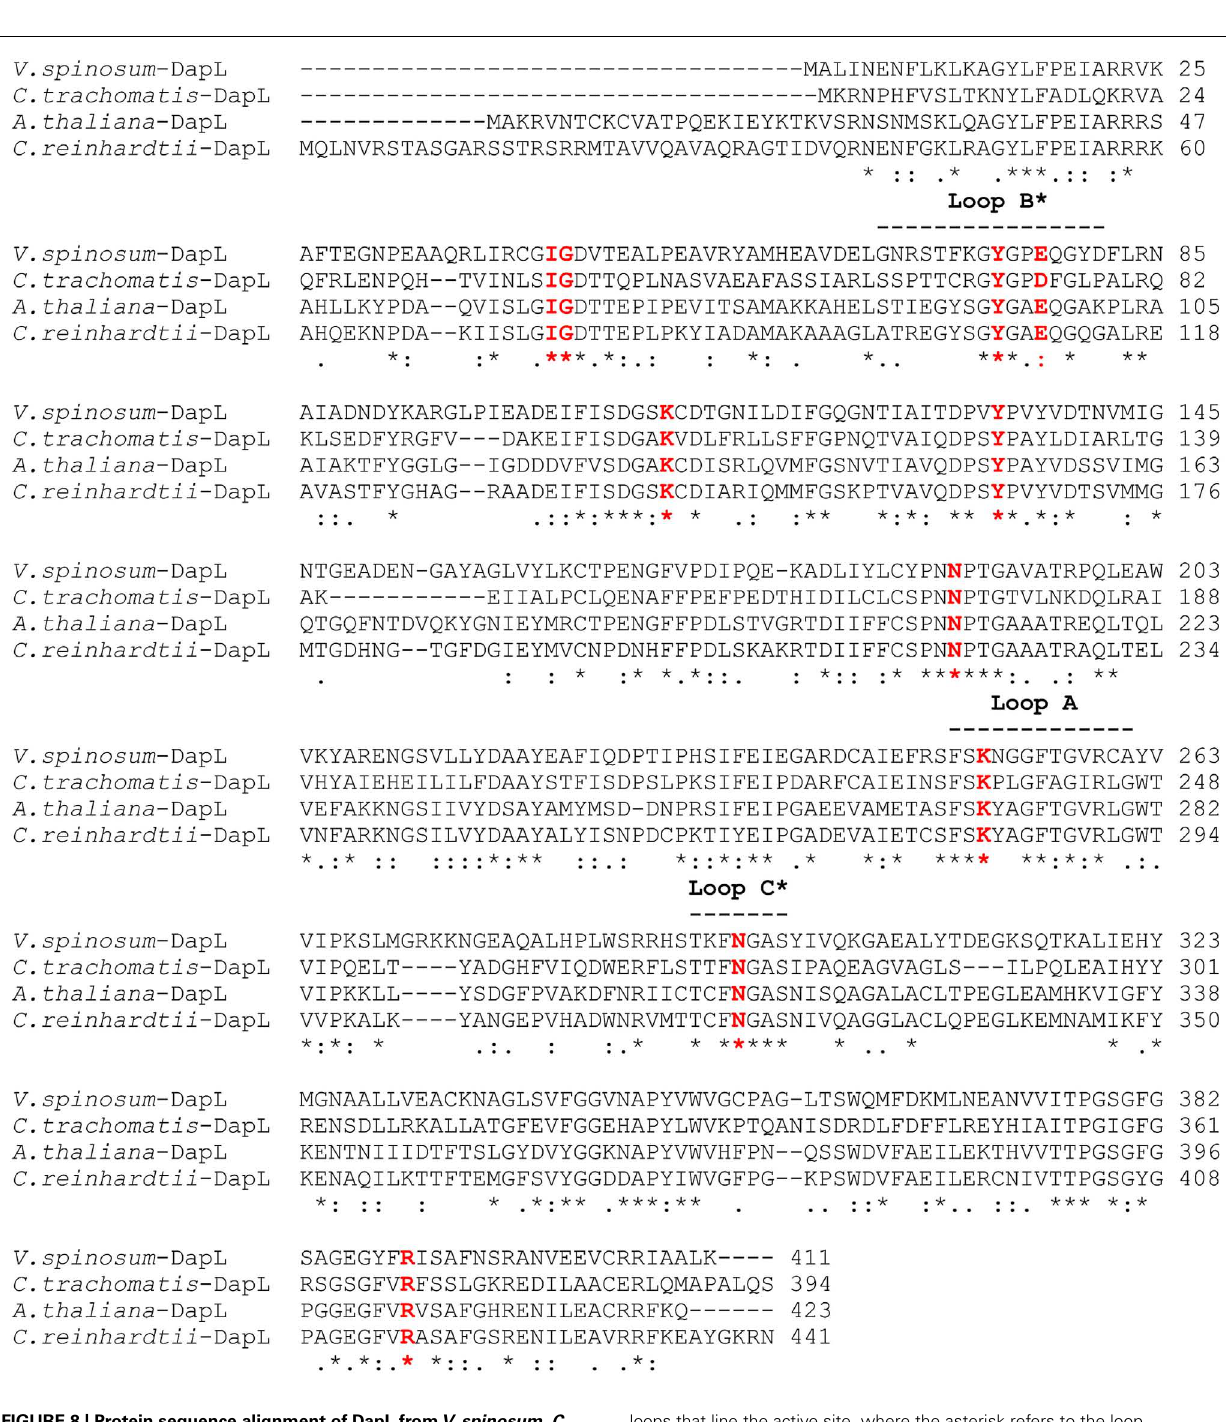
loops that line the active site, where the asterisk refers to the loop contributing to the active site of the opposing monomer.The ClustalW scores relative to the V. spinosum sequence were: vs. C. reinhardtii = 49 (length = 443 residues, identity); vs. A. thaliana = 45 (length = 426 residues); vs. C. trachomatis = 39 (length = 394